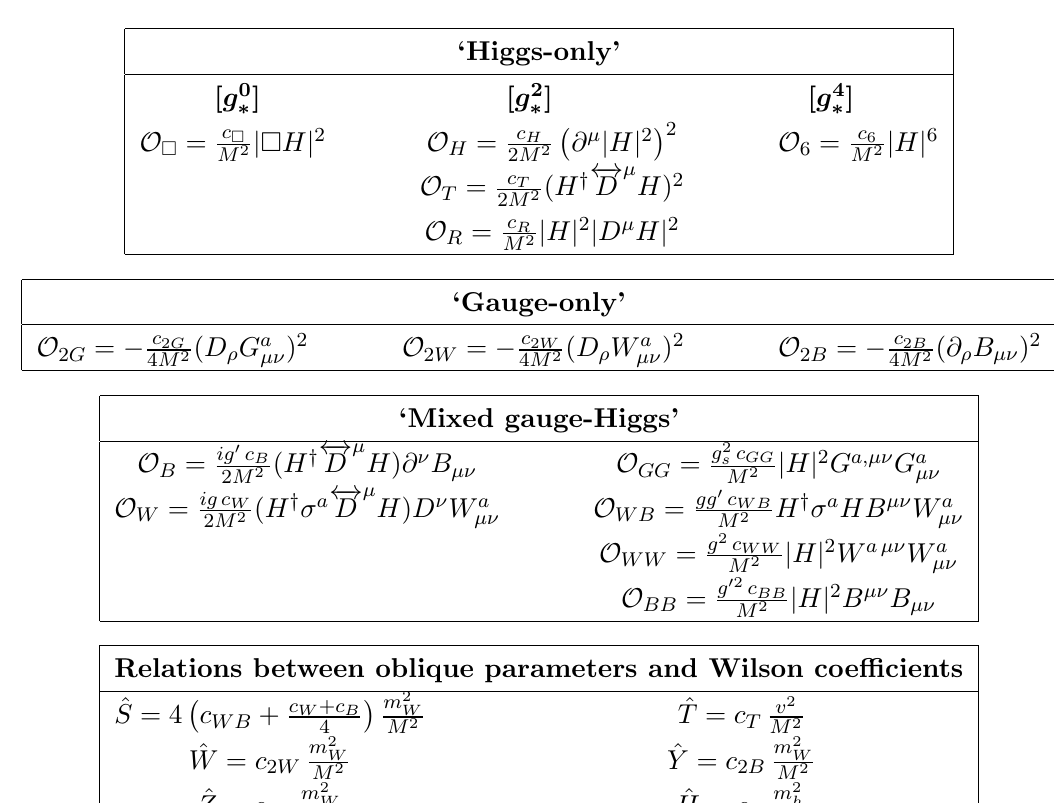
) as indicated (cid:3)